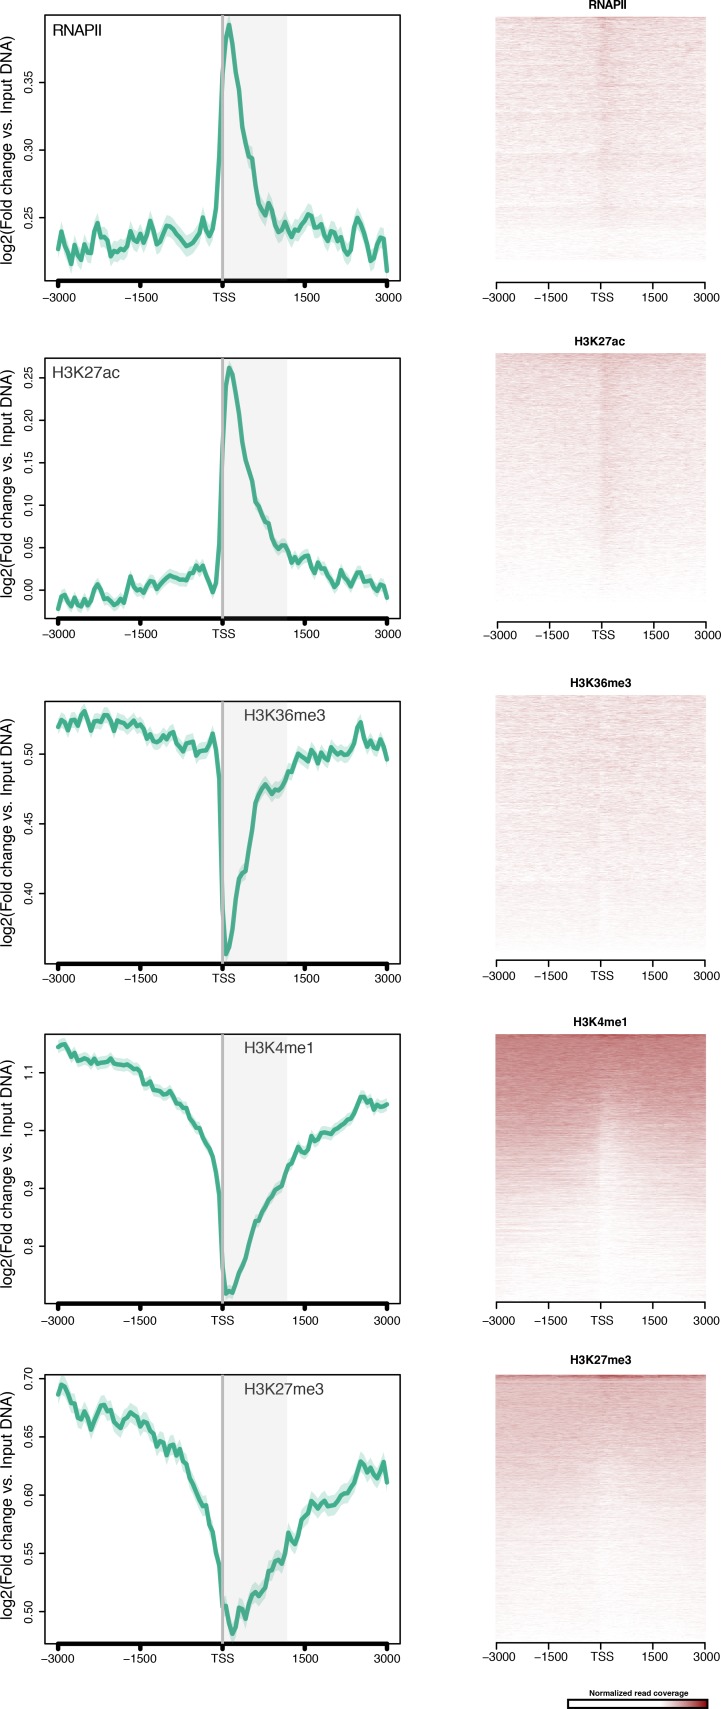
TSS-centred average input DNA normalised read coverage plots and heatmaps of RNAPII, H3K27ac, H3K36me3, H3K4me1 and H3K27me3 across Amphimedon protein-coding genes.The x-axis spans ± 3 kb around TSSs and represents the position within the gene relative to TSS. The y-axis represents the input DNA normalised enrichment for ChIP-seq reads in adult. The shaded gray area represents the average size of Amphimedon coding sequences.